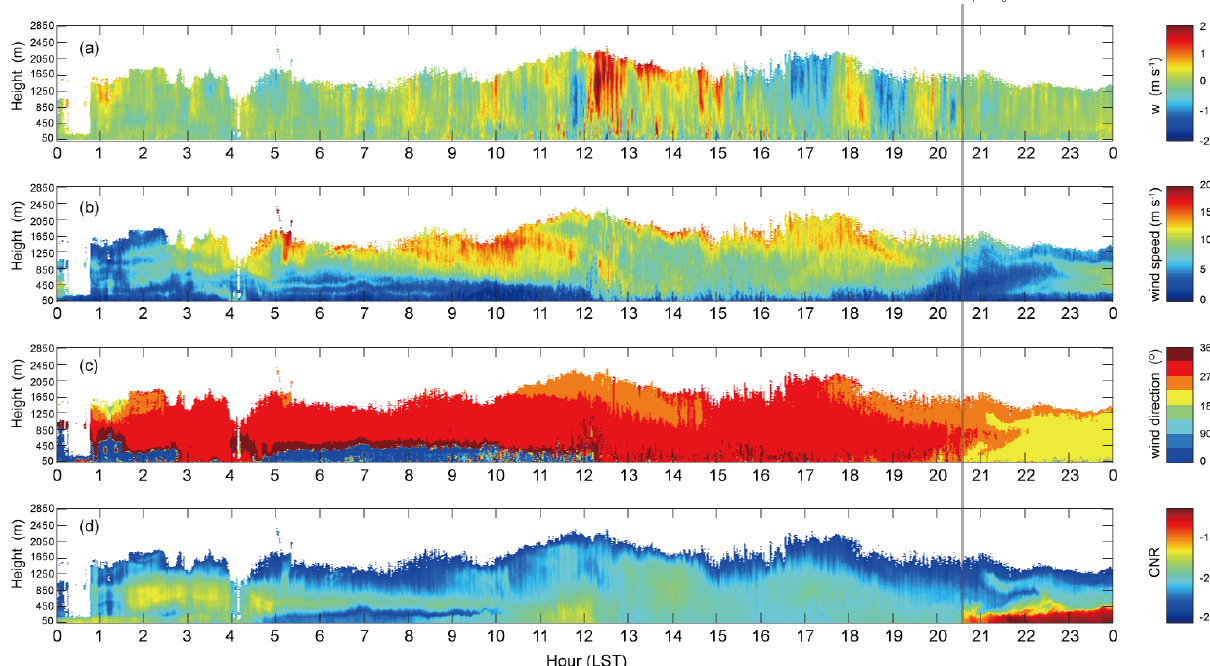
Figure 9. Doppler lidar observations of (a) vertical wind velocity, (b) horizontal wind speed, (c) wind direction, and (d) carrier–noise ratio (CNR) at IAP on 24 December 2015. The gray line indicates the time of HF passage at